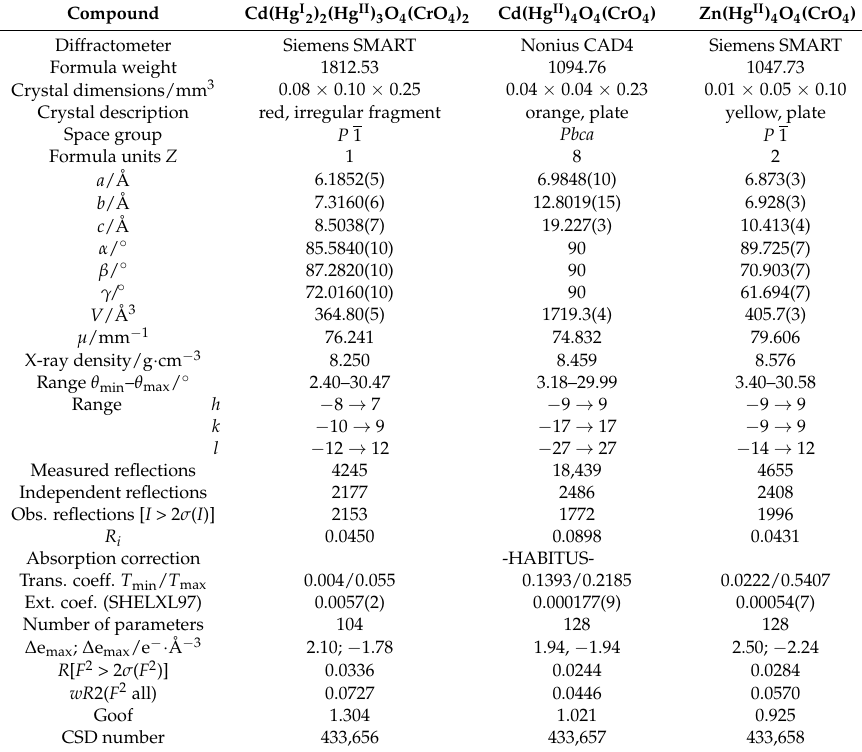
Table 3. Details of data collections and structure